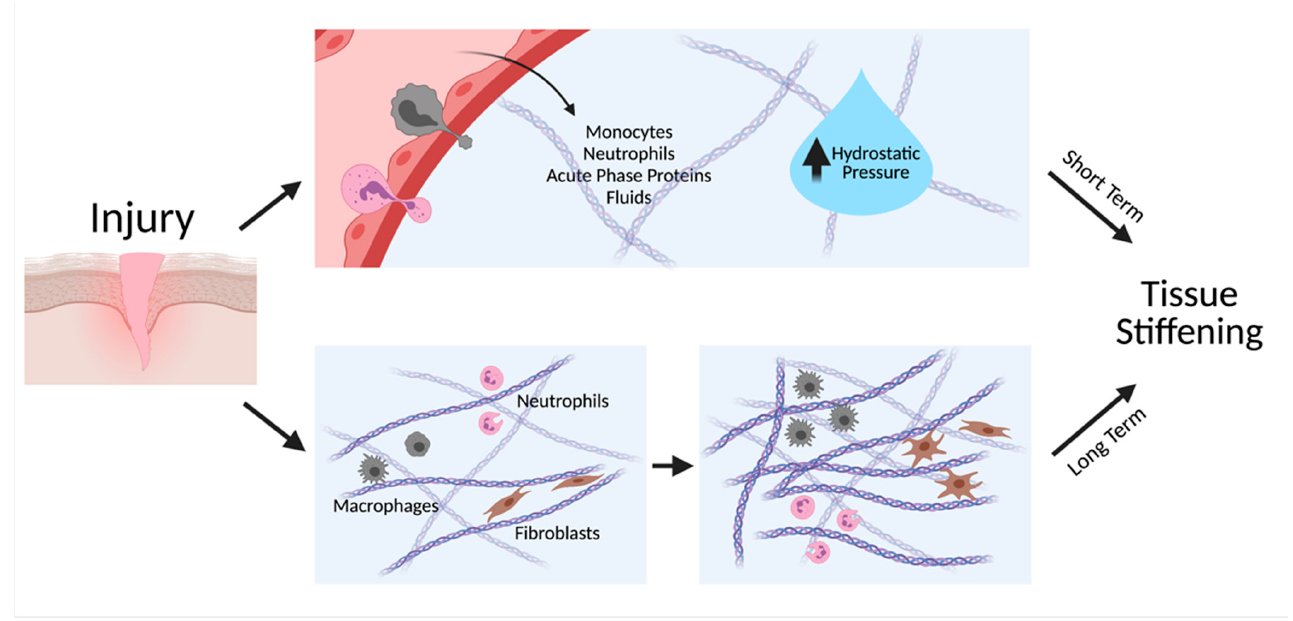
Figure 1. Inflammation facilitates both short-term and long-term tissue stiffening. Inflammatory cytokines induce vasodilation and an increase in permeability of vasculature, increasing leakage of fluids, proteins, and cells to the tissue, thereby increasing hydrostatic pressure. Long-term tissue stiffening occurs when immune cells and fibroblasts continuously deposit and remodel the ECM. Created with BioRender.com.